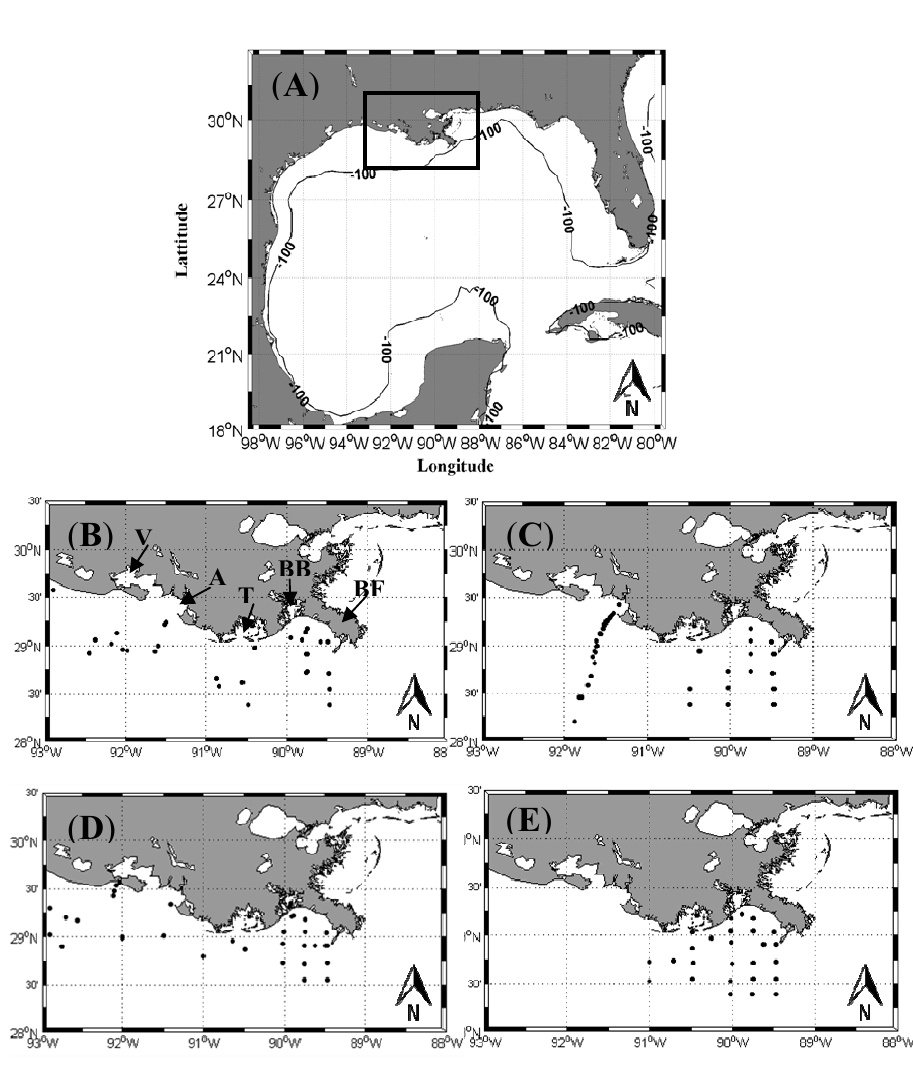
Figure 1. ( A ) Map of the study area in the northern Gulf of Mexico. Location of